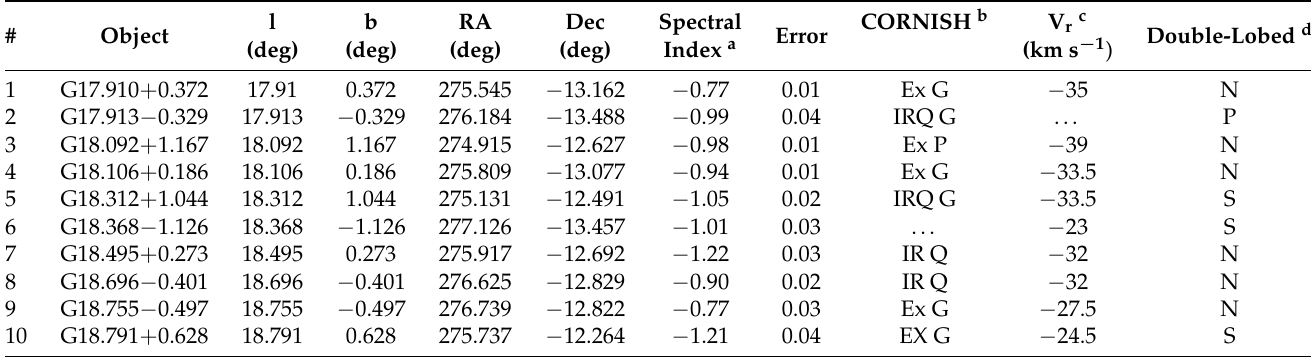
Table 2. Extragalactic sources.